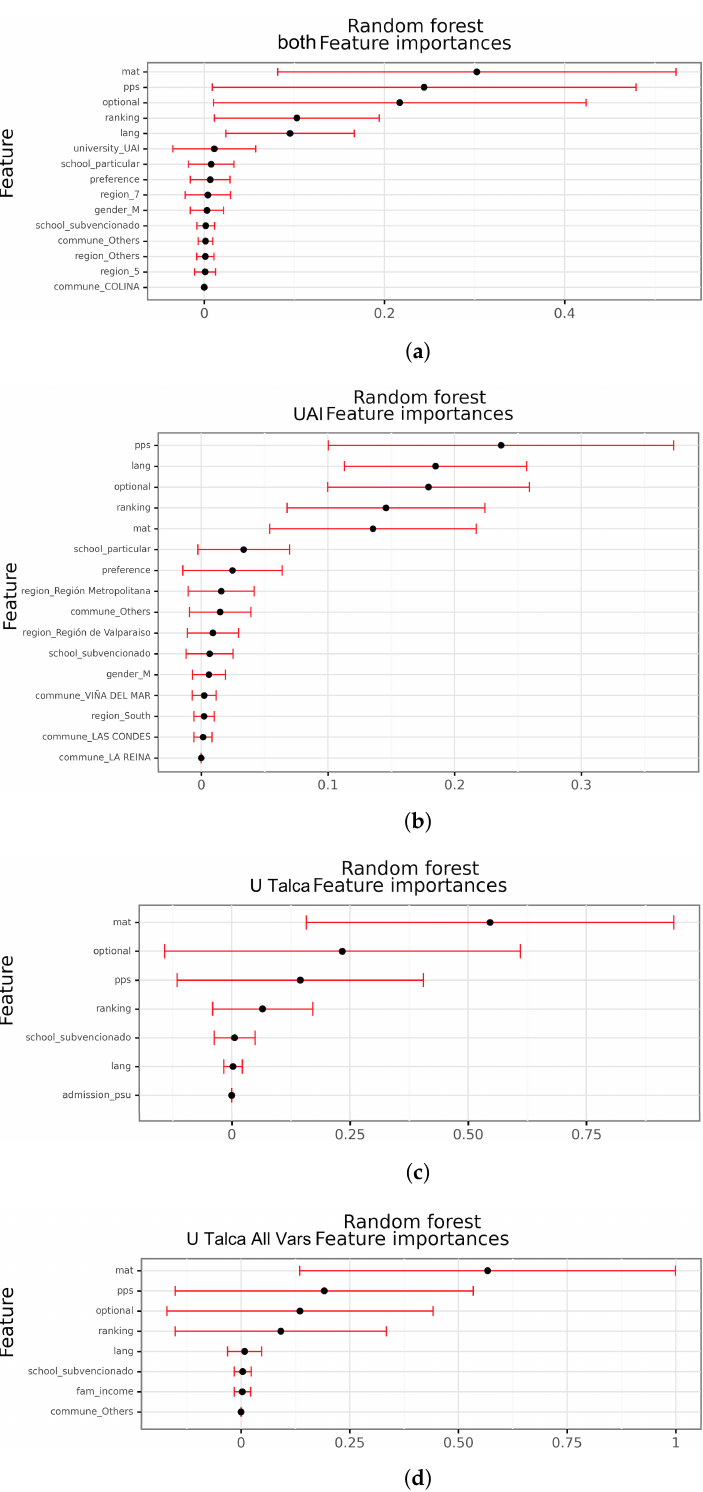
Figure A2. Feature importance for random forest. Black dots correspond to the means, while red bars represent one standard deviation. ( a ) Both. ( b ) UAI. ( c ) U Talca. ( d ) U Talca All